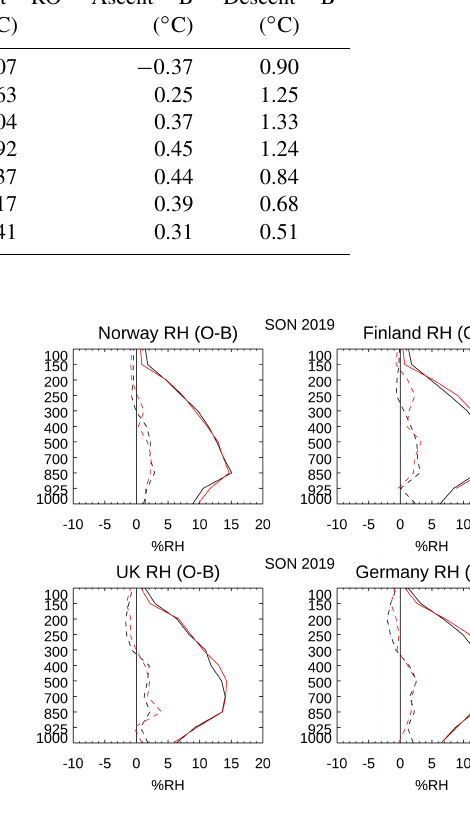
Figure 15. Figure 15 is the same as Fig. 10 but for relative humidity – up to